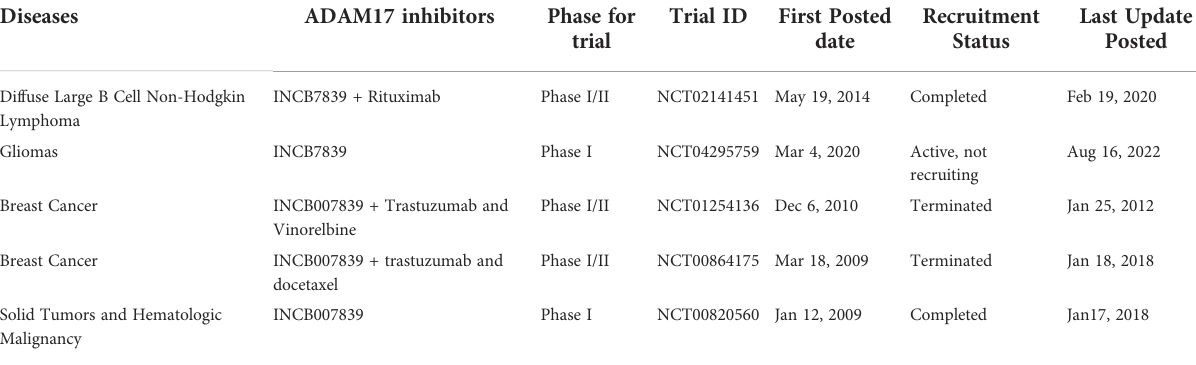
TABLE 3 Currently approved clinical trials using ADAM17 inhibitors for tumor